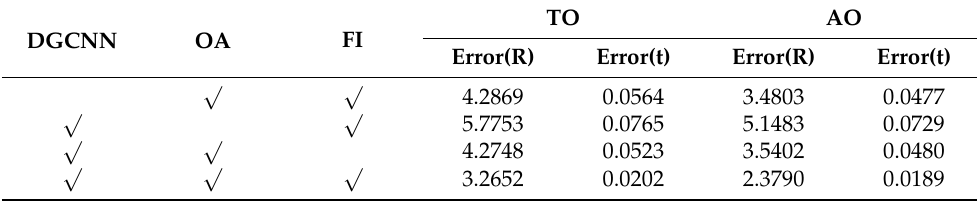
Table 8. Ablation studies.